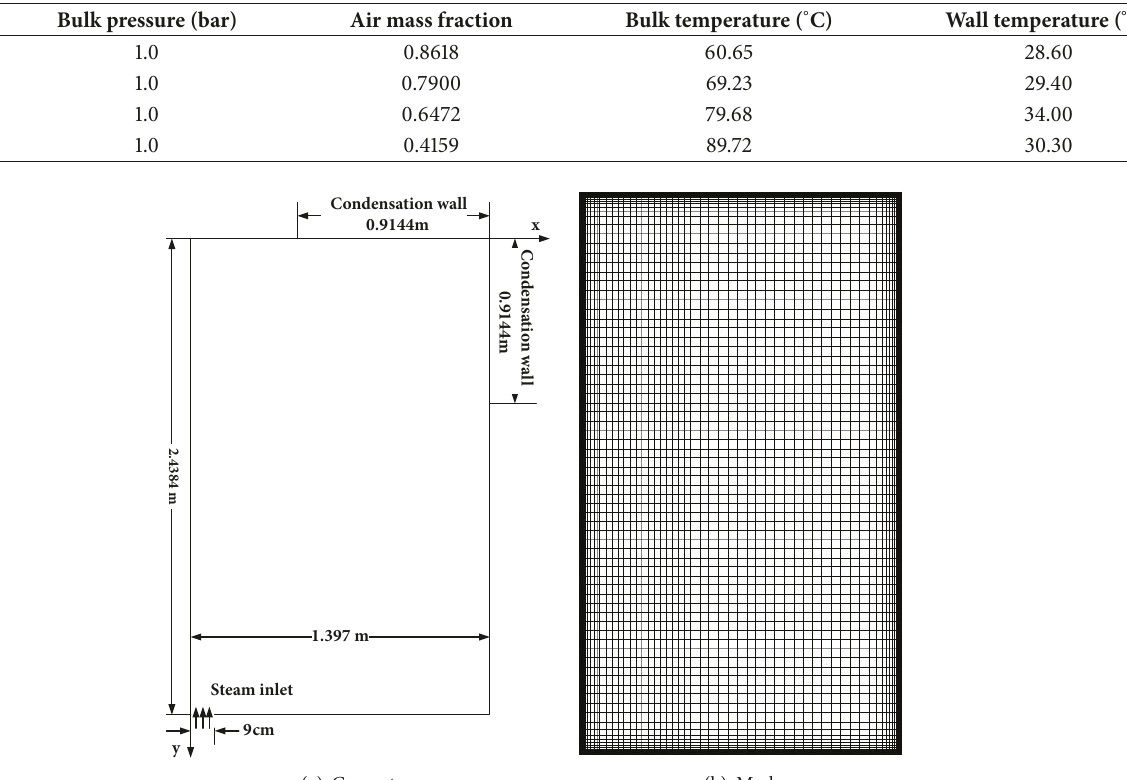
Figure 3: Geometry and mesh of Anderson’s scaled AP600 containment experiments. (a) Geometry. (b) Mesh.